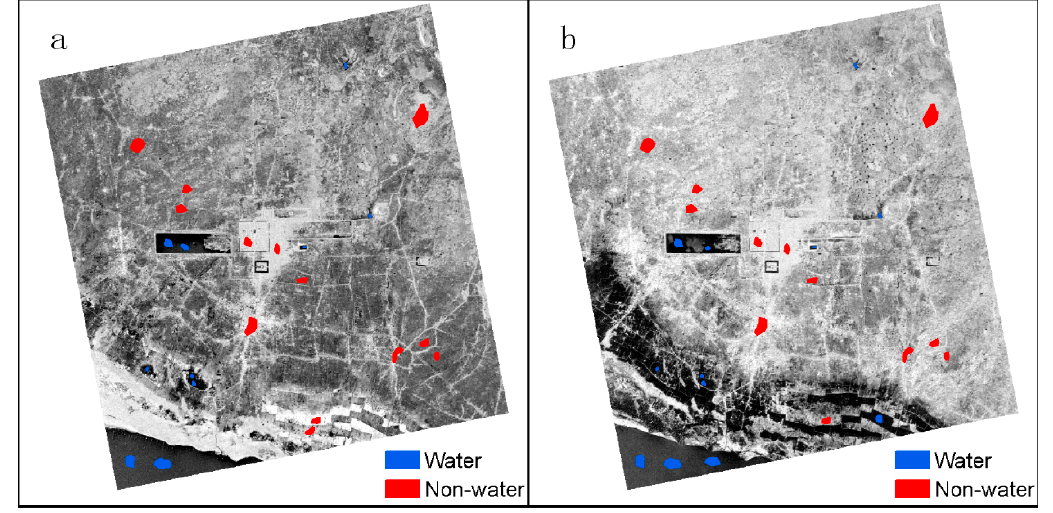
Figure 4. ( a ) Training samples for the SAR image acquired during dry season of February 2008; ( b ) Training samples for the SAR images acquired during flood seasons.